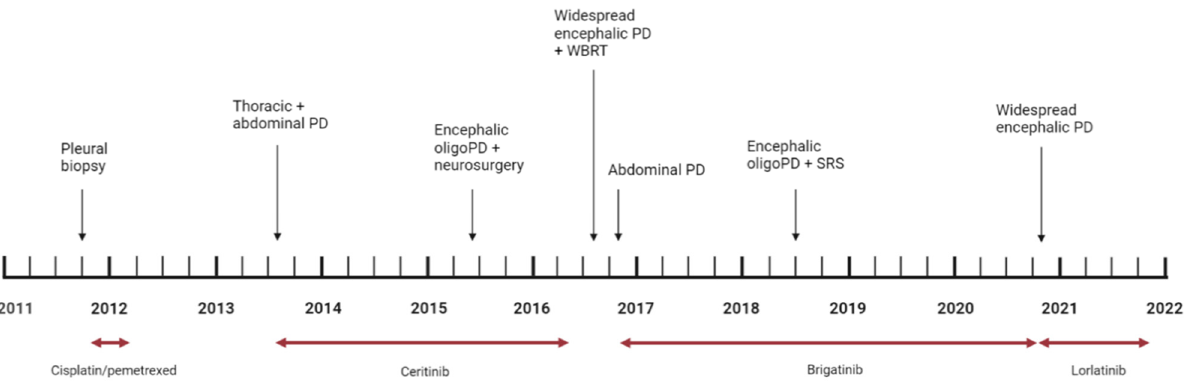
Figure 1. Patient XX oncological history. PD: progressive disease; oligoPD: oligoprogression; WBRT: whole brain radiotherapy; SRS: stereotactic radiosurgery.